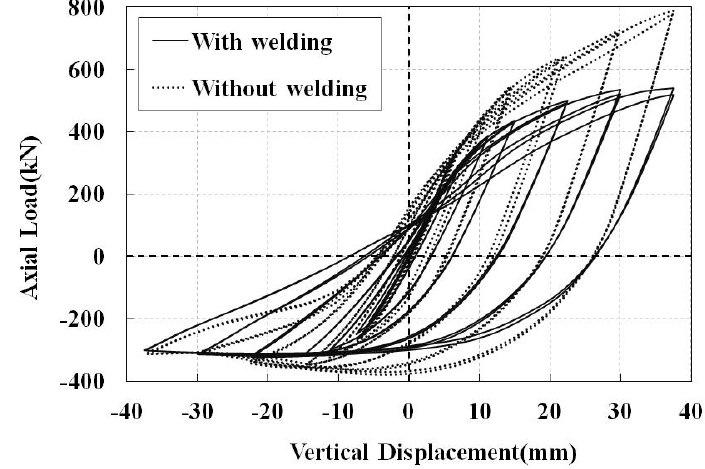
Figure 6. Hysteresis diagrams of the non-retrofitted J1 model with and without considering the welding process.